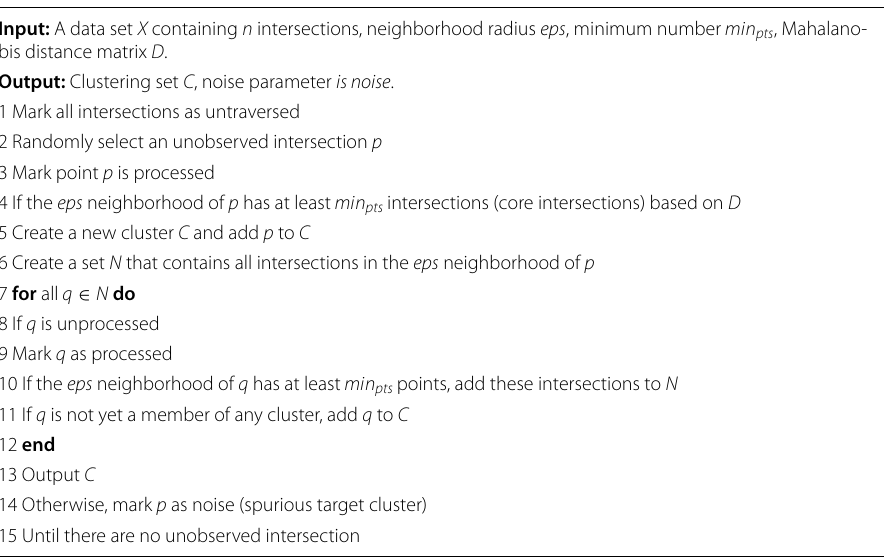
Table 2 M-DBSCAN algorithm Algorithm 2:M‑DBSCAN